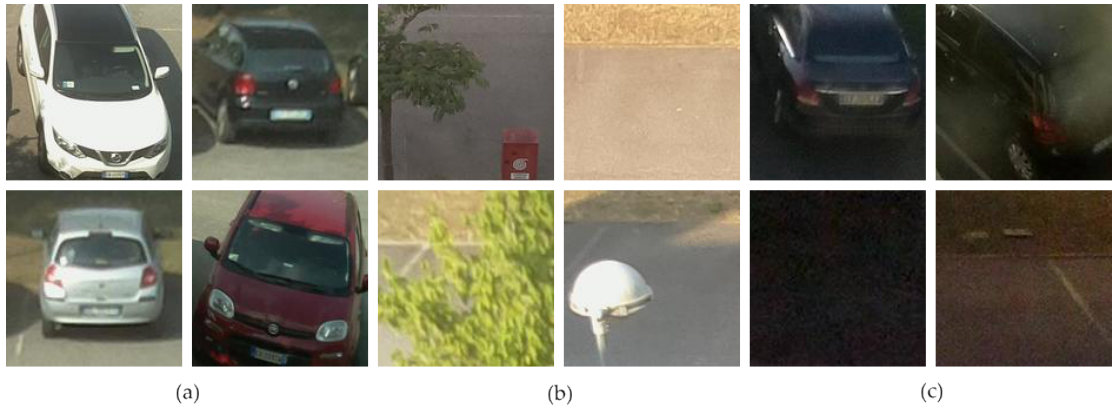
Figure 5. Parking spaces (patches) from CNRPark + EXT dataset [5]: ( a ) occupied patches; ( b ) empty patches; ( c ) dark or night time